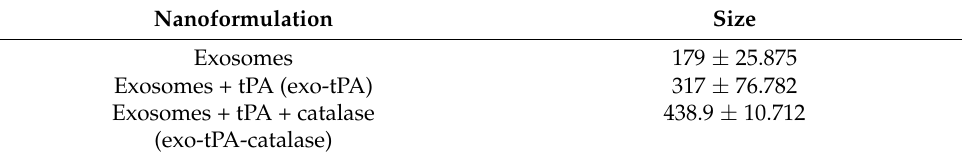
Figure 1. A. Schematic of the exosomes’ formulation. Exosomes were first treated with EDC/NHS 243 and subsequently reacted with tPA and/or catalase. (i). Exosomes conjugation with tPA, and (ii) 244 Exosomes conjugation with tPA/catalase. B. TEM image of the exosome and flow cytometry char- 245 acterization of exosome marker CD81. Scale bar 100 nm. 246